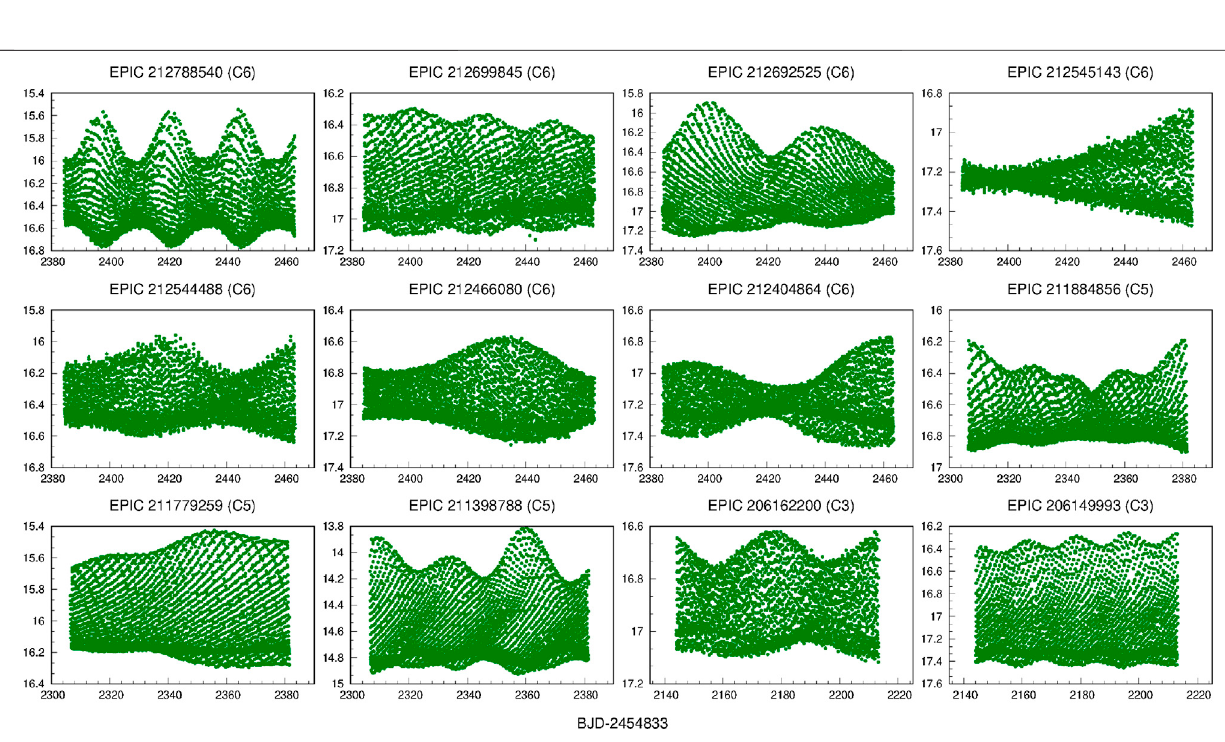
Frontiers in Astronomy and Space Sciences |